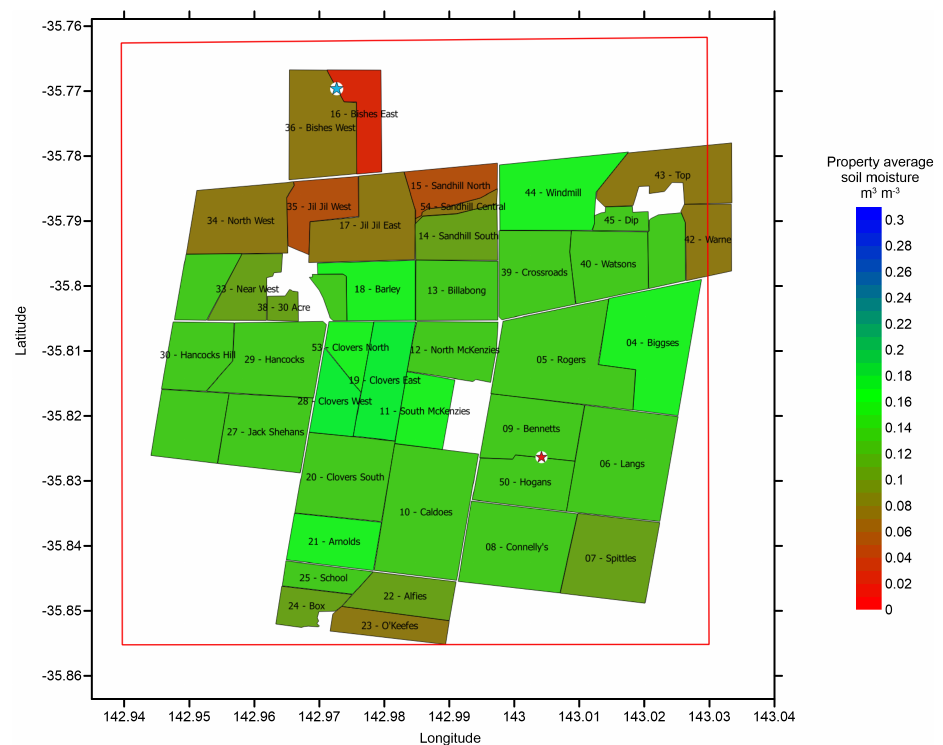
Figure 10. Location of target properties within the intensive-scale survey area (red box) and property-average soil moisture content for March 2017. Blue and red stars indicate the location of the Bishes and Bennetts cosmic-ray neutron